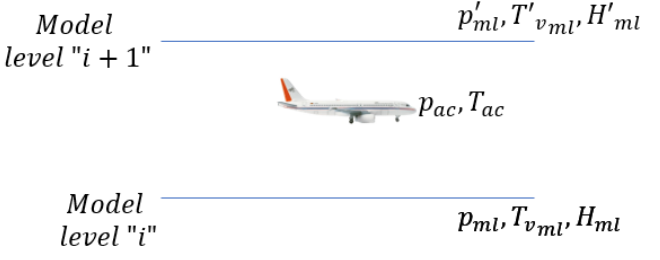
Figure 7. Computation of reference surface values and temperature lapse rate for estimating the barometric altitude from a pressure and temperature measurement at